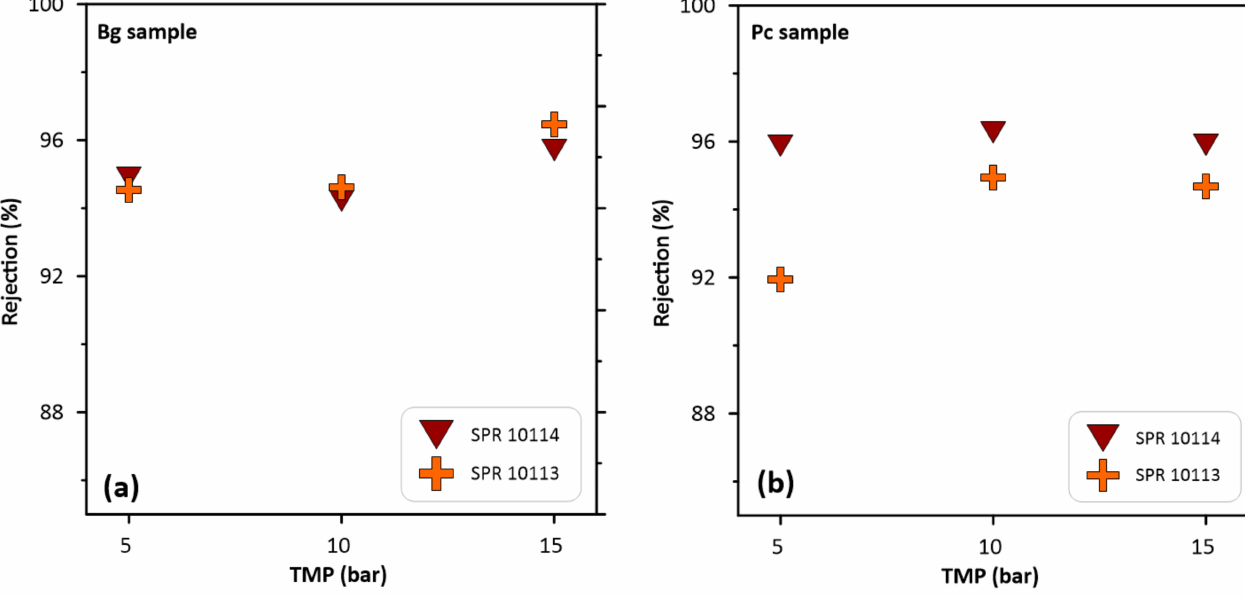
Figure 5. Effects of TMPs on fluoride rejection in the ( a ) Bg and ( b ) Pc permeates produced by using the SPR 10113 and SPR 10114